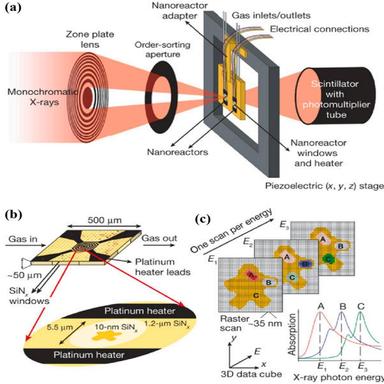
(a) Diagram of the in-situ STXM technique. (b) Close-up of the nanoreactor, showing the windows and the embedded heater spiral. (c) Diagram of a typical STXM data acquisition method.